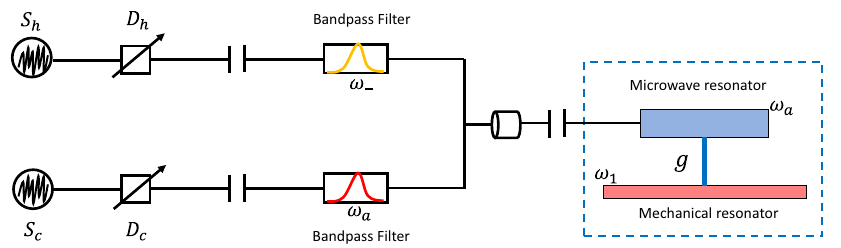
Fig. 7 Experimental feasibility. Realization of the proposed cooling scheme employing an electro-mechanical system, an analog of the optomechanical system in Fig. 1. In this system, a mechanical resonator of frequency ω 1 is parametrically coupled (with a coupling strength g ) to a superconducting microwave resonator 40 of frequency ω a or a qubit 41,42 or a microwave circuit 13,43,44 and the system is placed inside a dilution refrigerator 13,40 . The multimode circuit electro-mechanical system can be considered for simultaneous cooling of the multiple mechanical resonators 14 . The microwave resonator is driven by carefully fi ltered hot and cold white noise sources S c , and S h , respectively. The amplitude of these drives is controlled by attenuators D c and D h , respectively. The white noise sources can be realized by considering copper thin- fi lm resistors 67 , or arbitrary waveform generators can be used to produce noisy electric fi elds to drive the electrical component of the electro-mechanical system, and a hot bath of very high-temperature T h ~ 9500 K can be engineered 78 . The bandpass fi lters which yield effective Lorentzian form spectra of the cold and hot baths centered at frequency ω a , and ω − can be implemented by coupling two microwave resonators designed at frequency ω a , and ω − , respectively 67,79 . In a non-thermal bath-induced cooling, the white noise source S h can be replaced by a squeezed electronic noise source 78 . For a very large squeezing parameter, the squeezed electronic noise source can be realized by considering an on-chip micromaser setup, where the interactions between a two-level system and a microwave resonator are tunable and can be turned on and off repeatedly 75 .